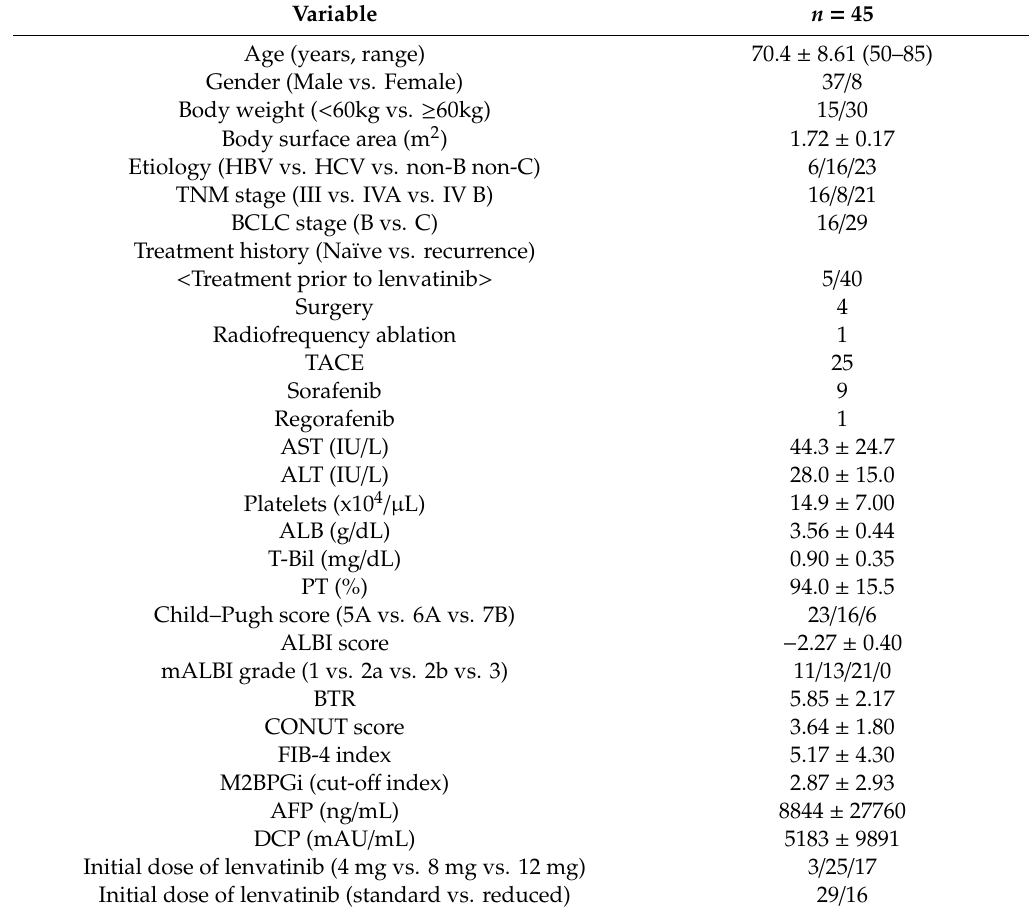
Table 1. Baseline characteristics of